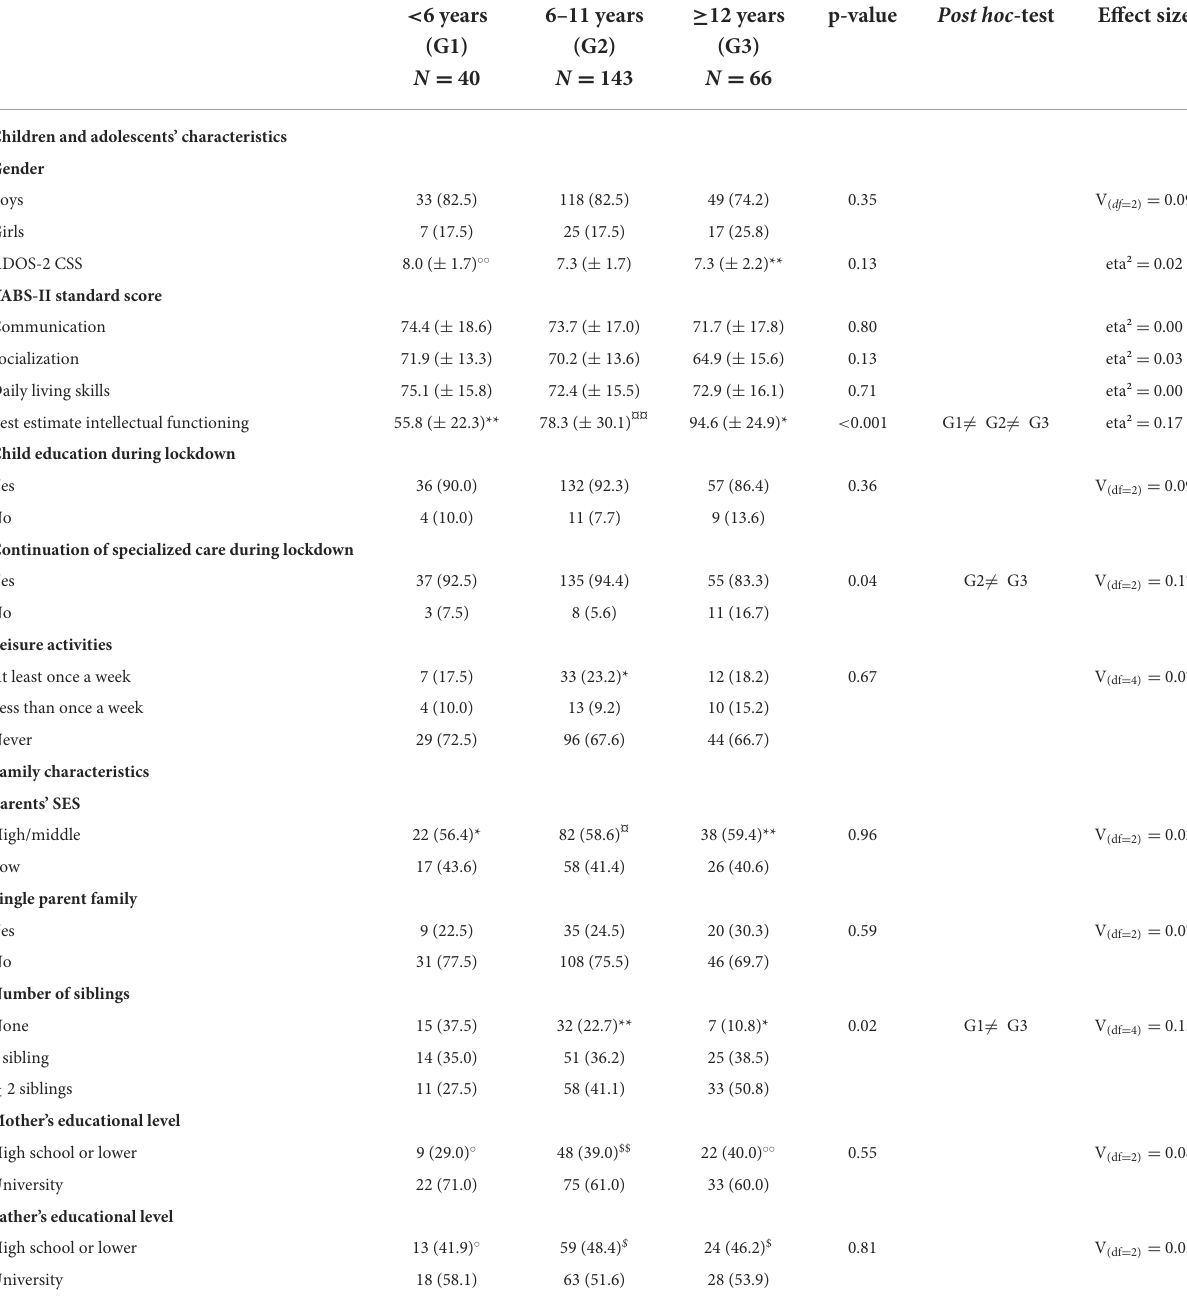
TABLE 1 Children, family, and socio-demographic